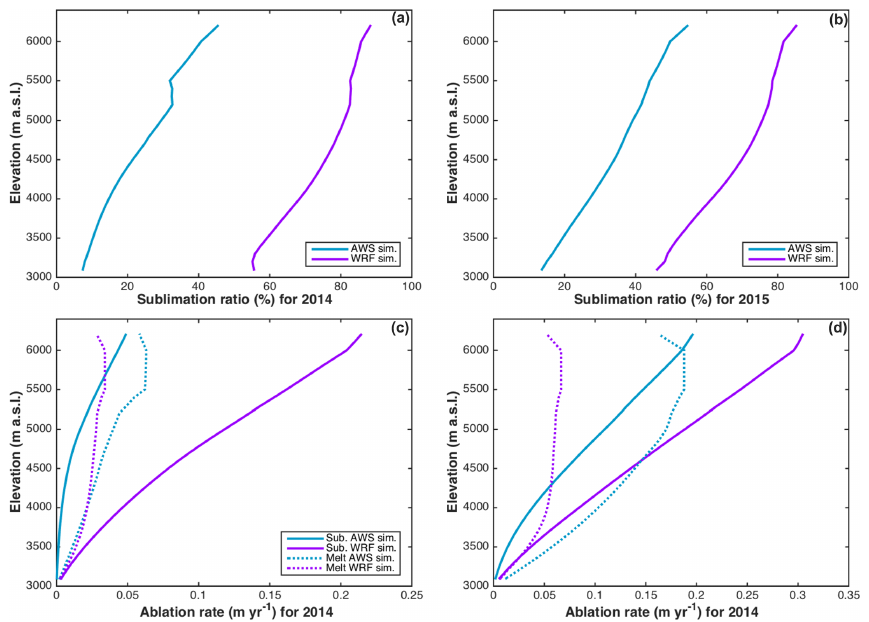
Figure 8. Simulated annual sublimation ratio against elevation band using AWS (blue) and WRF (purple) forcing for 2014 (a) and 2015 (b) . Simulated annual average total ablation (sublimation and melt) against the elevation using AWS and WRF forcing for 2014 (c) and 2015 (d) .